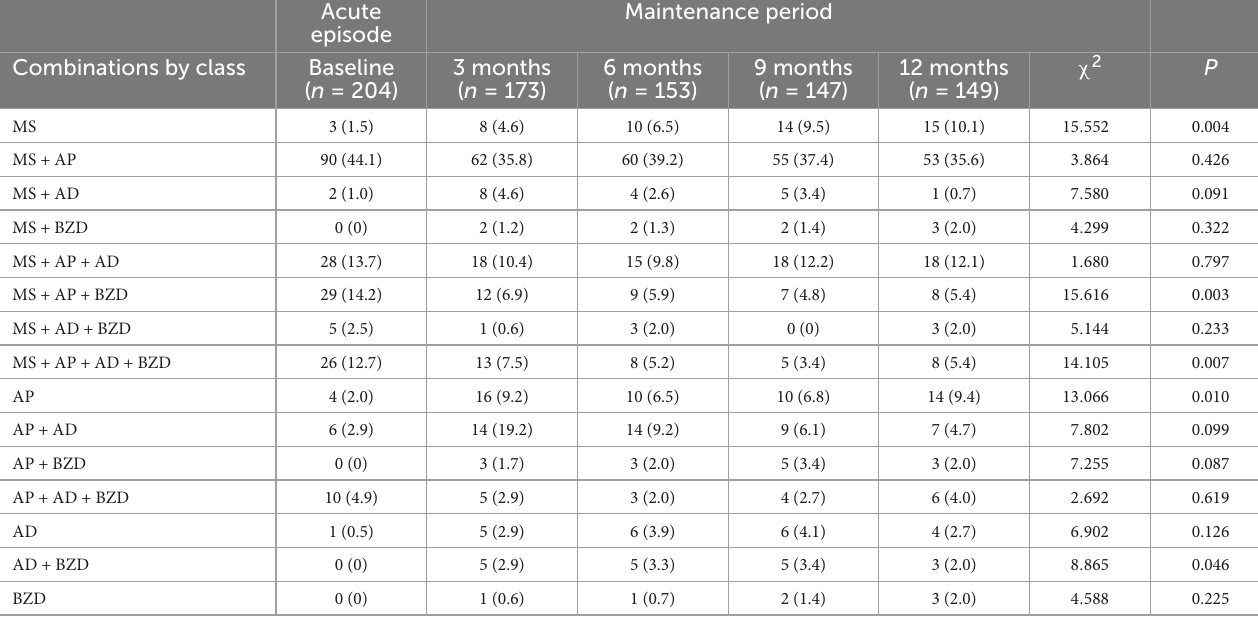
Maintenance period